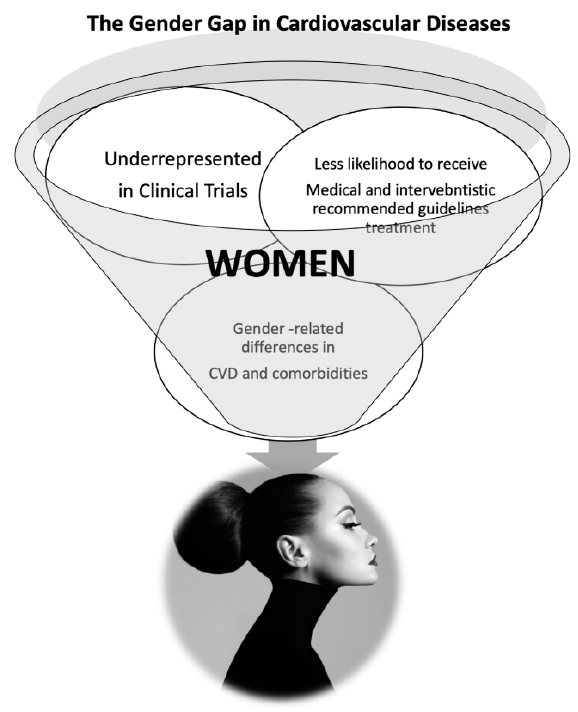
Figure 5. The gender GAP in CVD.